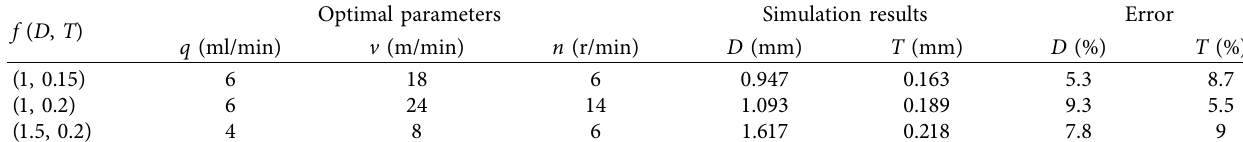
Table 7: Optimal solutions and simulation results.